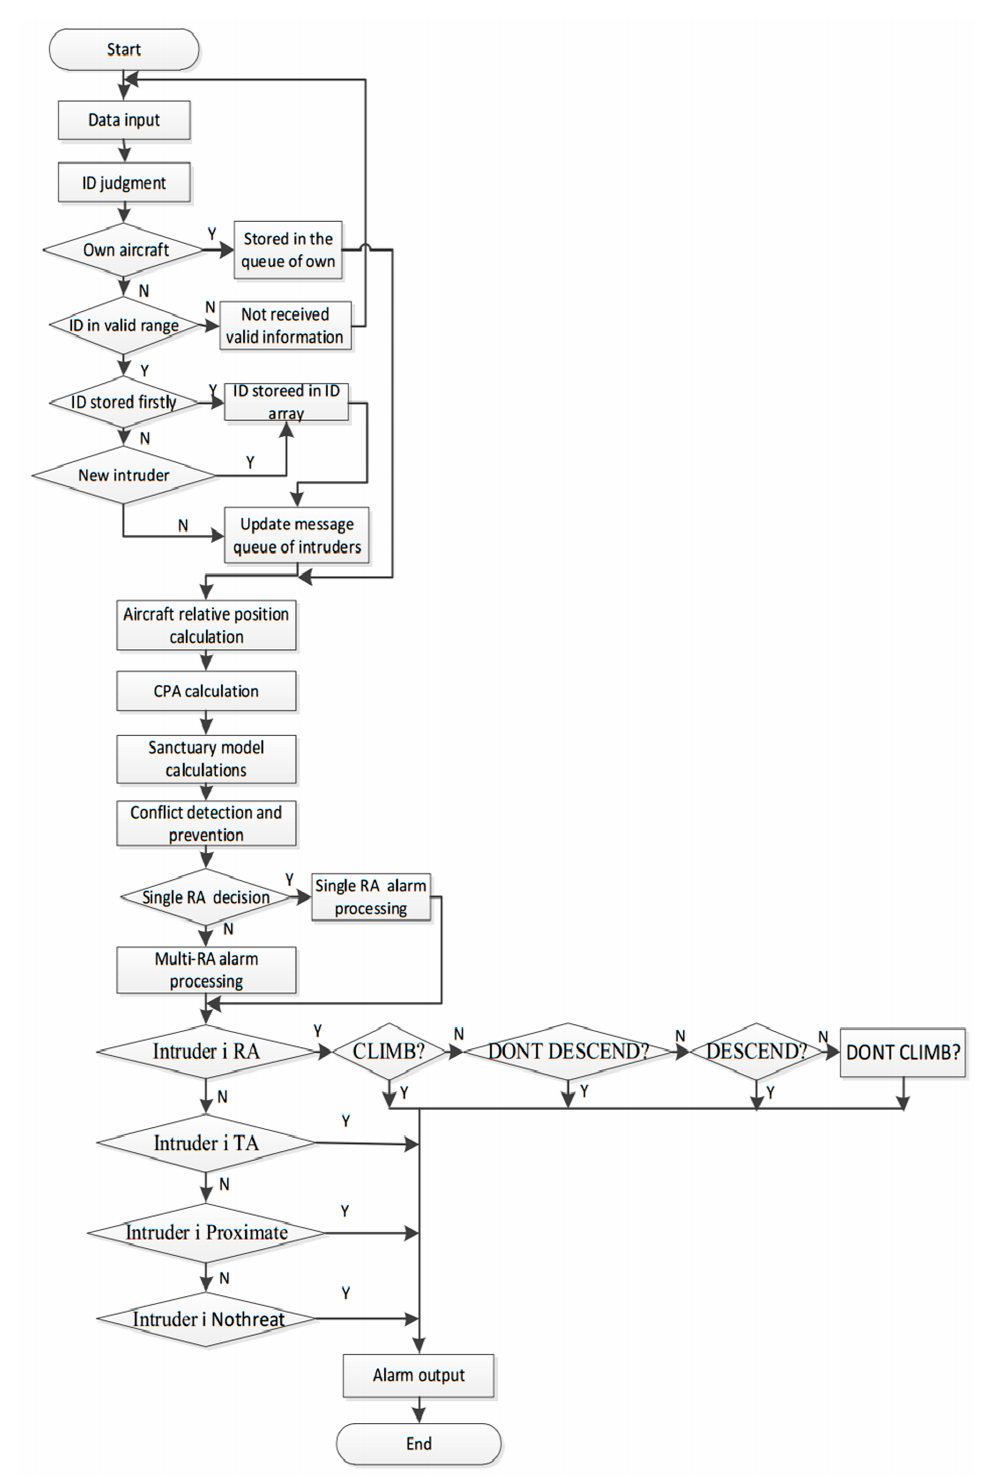
Figure 12. TCAS algorithm flowchart.